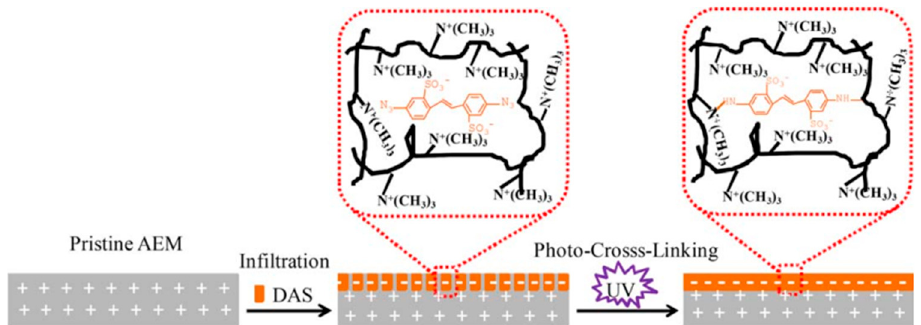
Figure 8. Surface modification of an anion exchange membrane (AEM) by infiltration and photo-cross-linking using 4,4-diazostilbene-2,2-disulfonic acid disodium salt (DAS). The azido group in DAS reacted to a nitrene group under UV irradiation which immobilized it on the membrane surface, thereby creating covalent cross-linking: The sulfonate group facilitated the water solubility and infiltration into the surface layer structure of the membrane, providing the negative charge groups and also improving the monovalent anion selectivity. Reproduced with permission from [57]. Copyrights 2018 American Institute of Chemical Engineers.